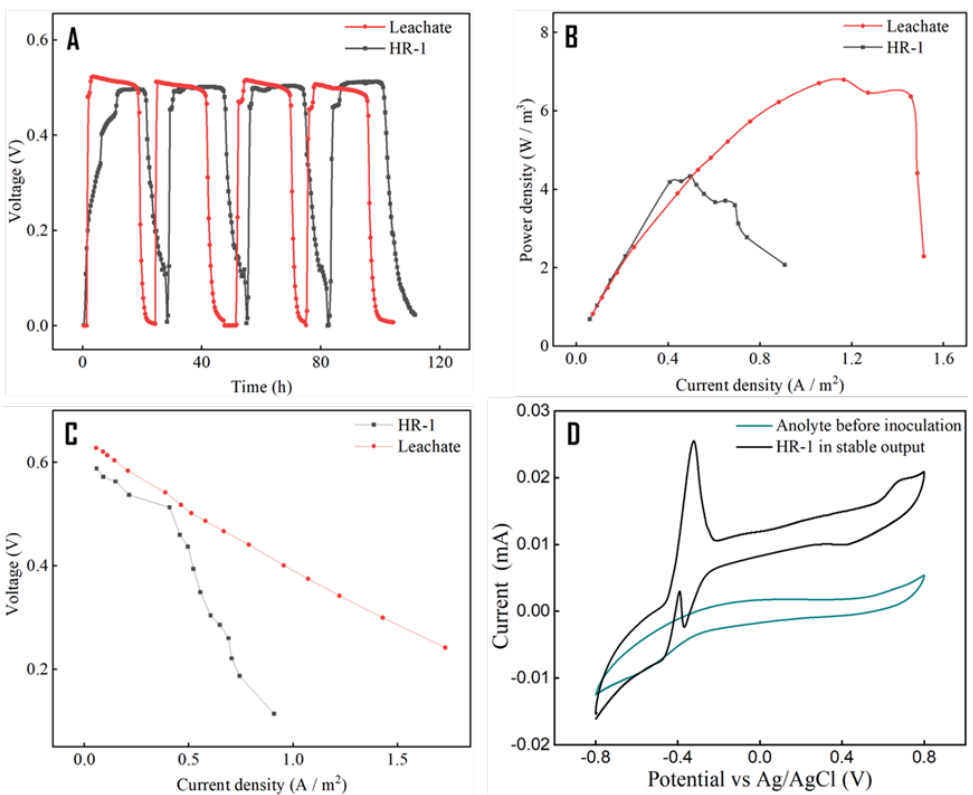
Figure 3. ( A ) Operation cycles of MFCs; ( B , C ) Polarization curves of leachate-fed MFC and HR-1-inoculated MFC; ( D ) CV curves of anolyte before Inoculation and HR-1-inoculated MFC in the stable phase.